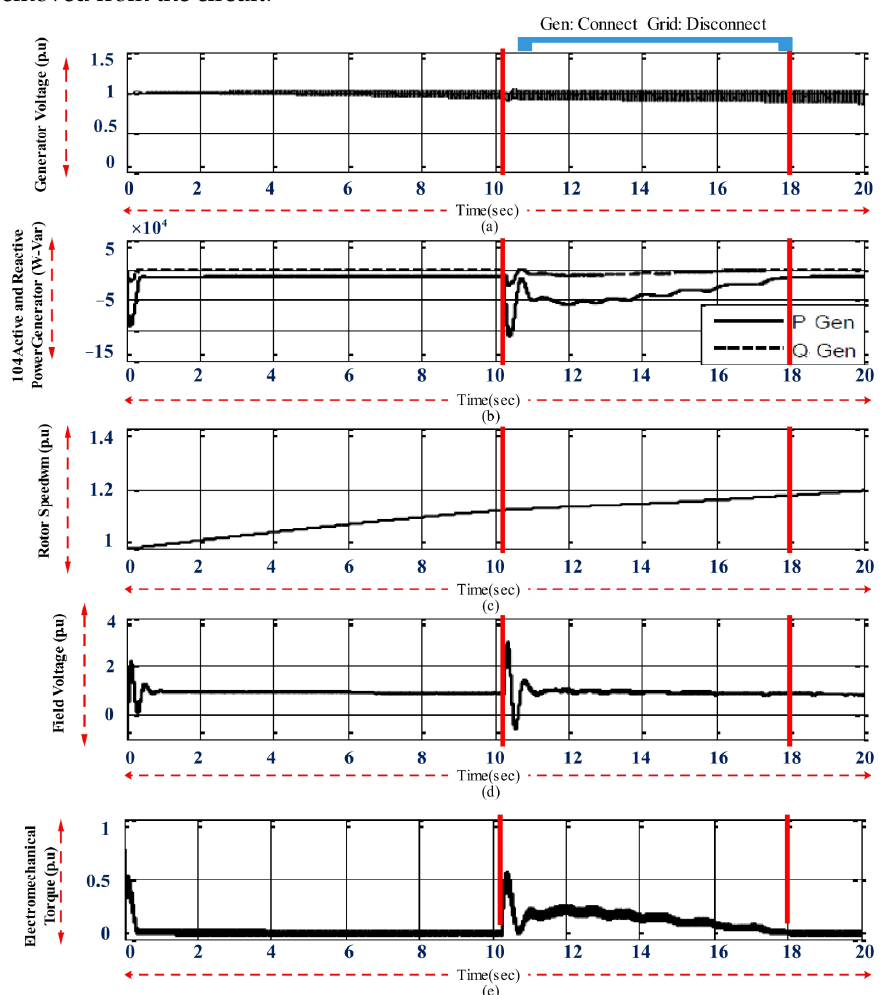
Figure 22. The behavior of the diesel generator in the microgrid in the state of connection to the grid and selected diesel (on-grid)—( a ) generator bus voltage; ( b ) active and reactive power exchange of the generator with the system; ( c ) angular speed of the generator; ( d ) excitation voltage; ( e ) electromechanical torque .